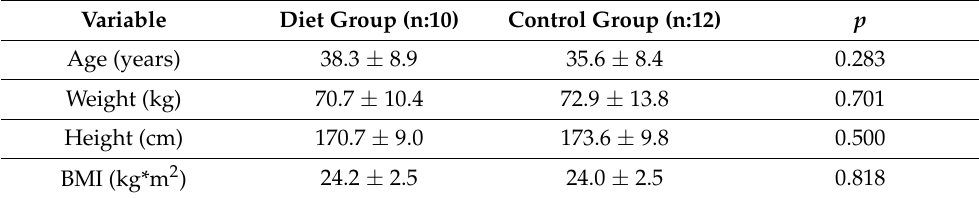
Table 1. Baseline